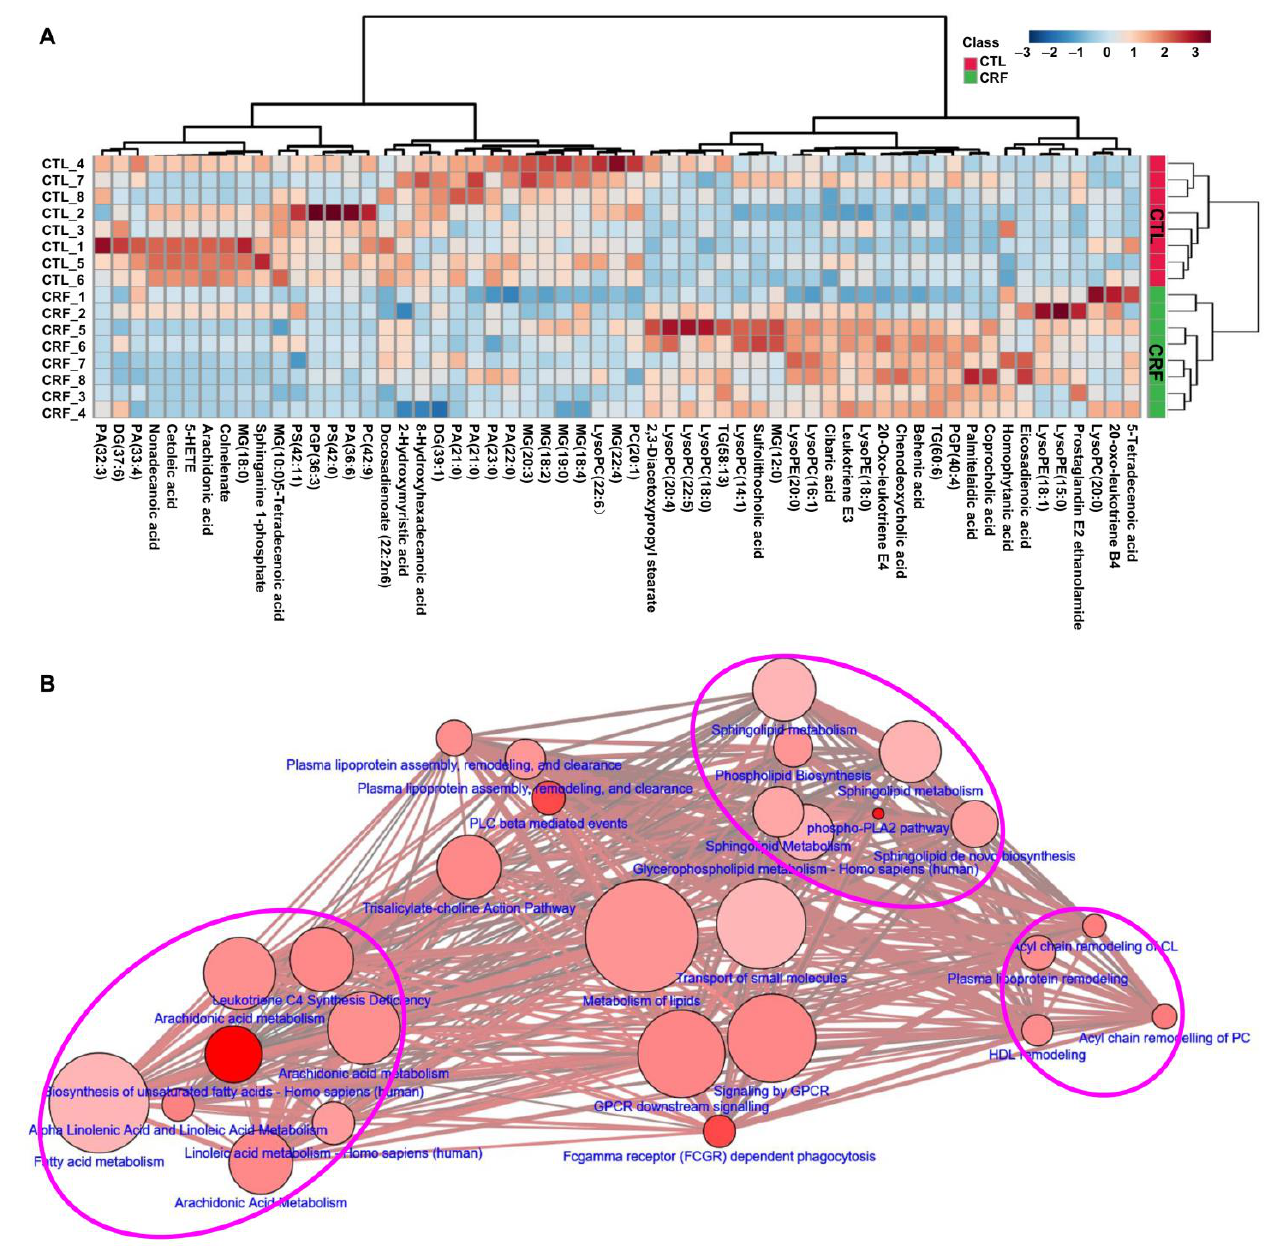
Figure 2. The dysregulation of lipid metabolic pathway participated in CRF. ( A ) Heatmap clustering analysis based on 58 lipid species from the CRF and control rats. ( B ) Metabolite pathway analysis of 58 lipid species by MetScape software running on cytoscape based on Kyoto Encyclopedia of Genes and Genomes (KEGG), Reactome, and SMPDB database. The node label color denotes the type of the metabolite sets. The size and color of each circle was based on pathway impact value and p -value, respectively. Node size indicates the amounts of metabolites found in metabolic pathway and more node size include the more amounts of metabolites in metabolic pathway. Node color indicates p -value. Red and pink indicate p < 0.0001 and p < 0.01, respectively.